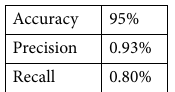
Table 4. Results of deep ensemble 2D CNN.